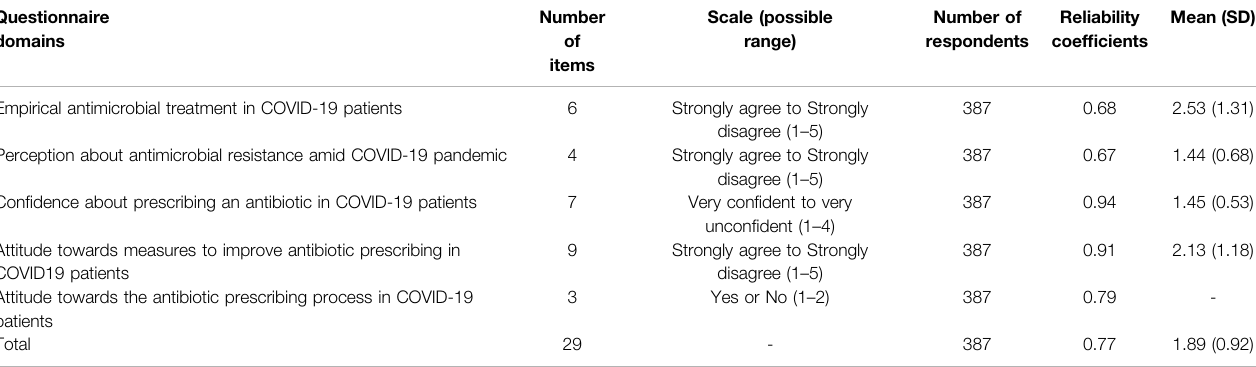
TABLE 1 | Number of items and respondents, reliability, and score distributions by domain included in the Perception and Attitudes of Physicians towards prescribing antimicrobials questionnaire.